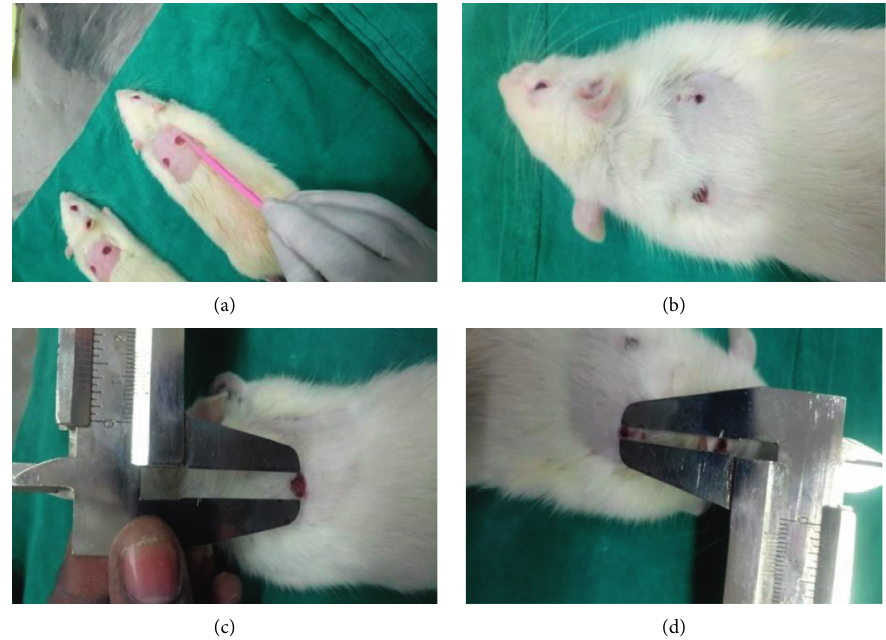
Figure 7: TSP gel wound healing ability in Wistar rats. (a) TSP gel application site (right side), (b) wound site reduction at TSP gel applied site (after 7 days), (c) wound site measurement of control (6.5mm) at 7 th day, and (d) wound site measurement of TSP gel applied site (3.5mm) at 7 th day. Values are expressed as mean ± SE ( n � 3), where p ≤ 0 .